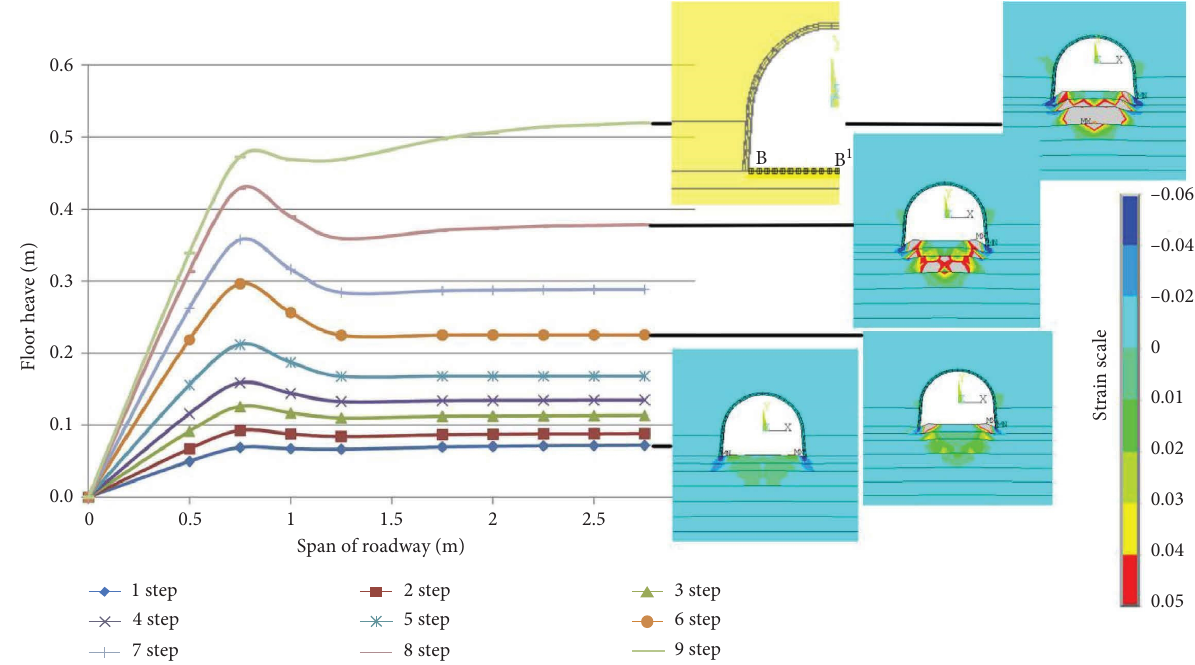
Figure 11: Floor heave on monitoring line B-B 1 and vertical plastic strain distribution around the